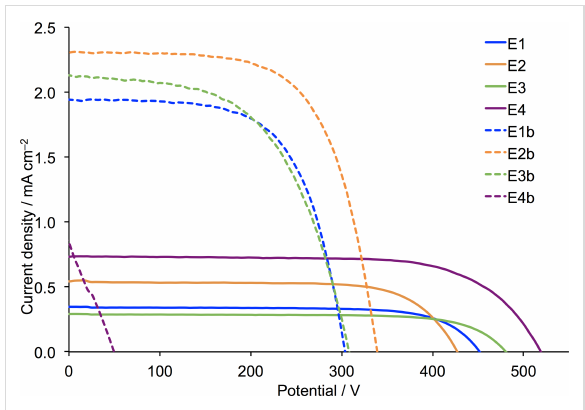
(Supporting Information File 1). The EQE spectra are